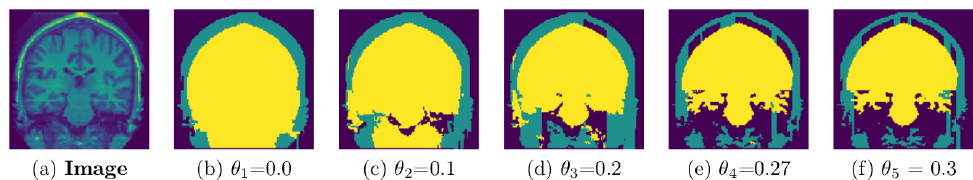
Figure 14. A representative coronal section from 3D MRI showing the separation of components for different thresholds: MRI from a single subject (OASIS data set) experimented using different thresholds and the nodes sample size is 20,000. GUBS is run on 3D and for visualization we take 2D at the same location for all experiments.